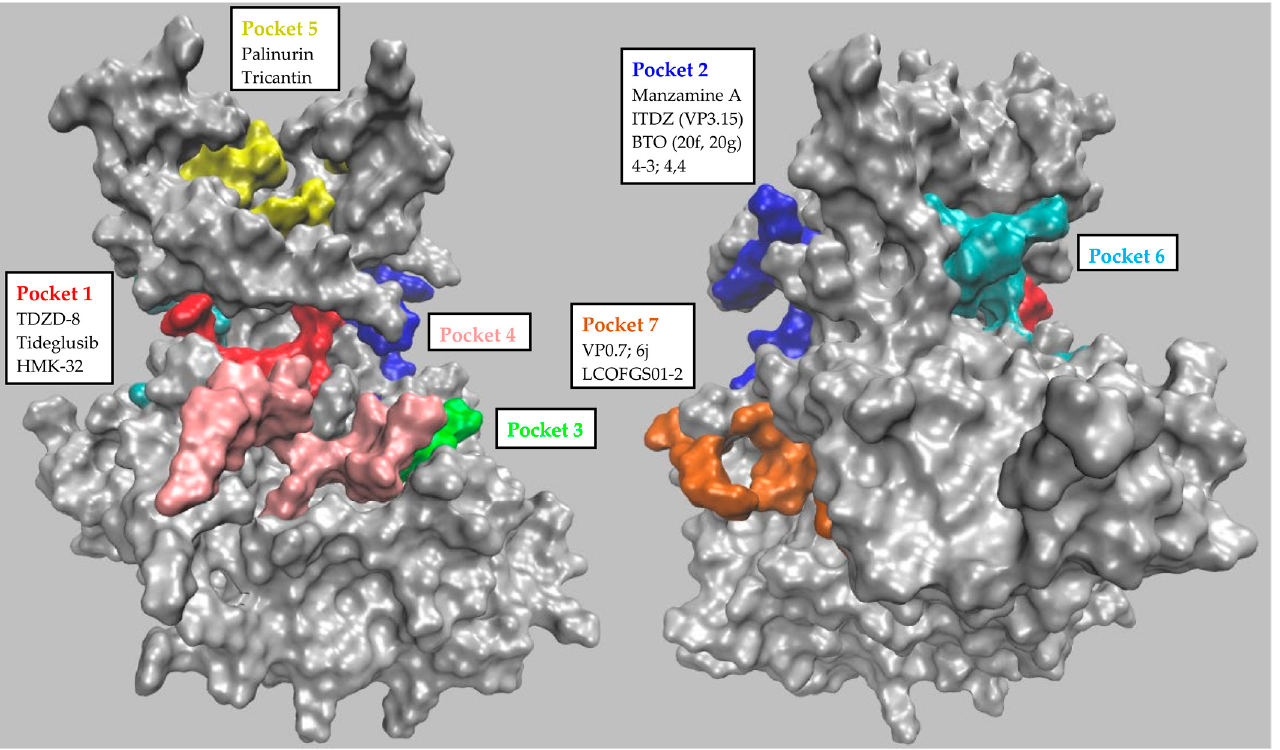
Figure 1. Representation of the main GSK-3 β pockets, as described in Palomo et al., 2011 [37]. The left and right panels contain the front and rear views, respectively.